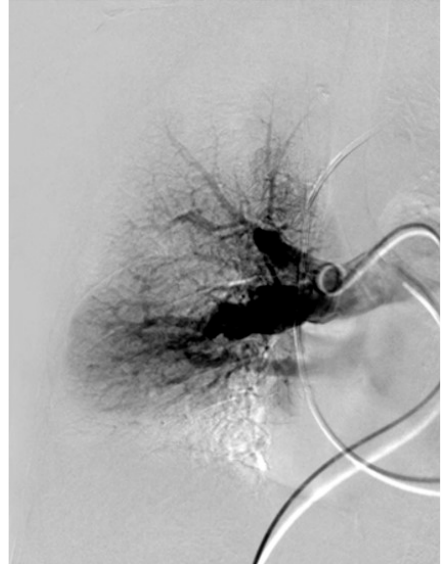
Figure 13. Angiography of the right pulmonary artery with webs of the apico-posterior artery of the upper lobe as well as peripheral.